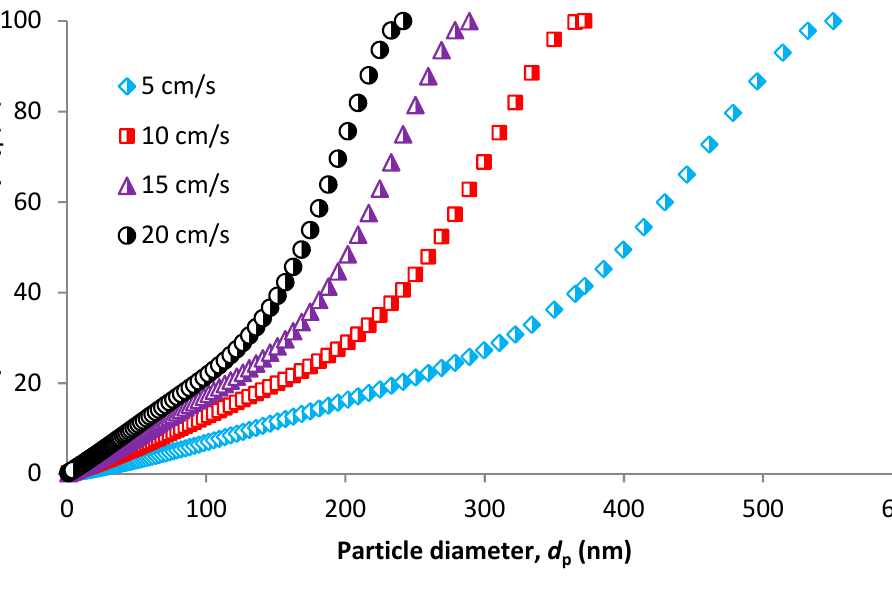
Figure 10. Impaction efficiency based on CPM model.